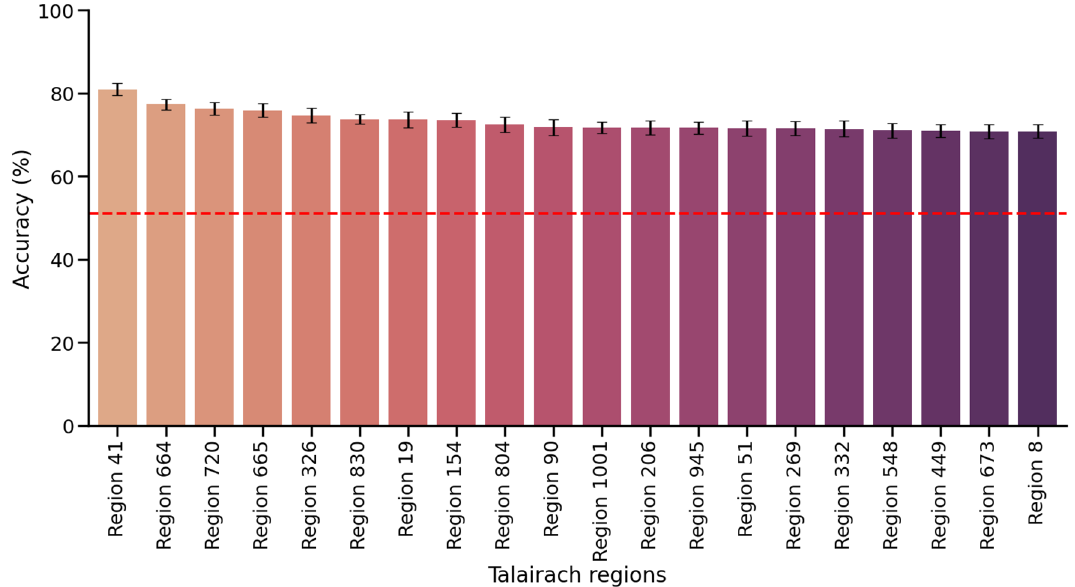
Figure 2. Top 20 Talairach regions by accuracy (%). The SL considered classifiers produced by base learners, each applied to a specific region. This shows the mean 5-fold internal CV accuracies, for the top 20 regions. The SL selected region # 41 to best distinguish anxious from non-anxious children. Other highly ranked regions include region # 664 (Right cerebrum, Limbic lobe. Posterior cingulate white matter) and region # 720 (Left Cerebrum, Transverse temporal gyrus, Brodmann area 38). All error bars represent the standard error of each participant across inner-CV folds from the SL. Red stripped line represents baseline accuracy for the majority group (51.1 %).